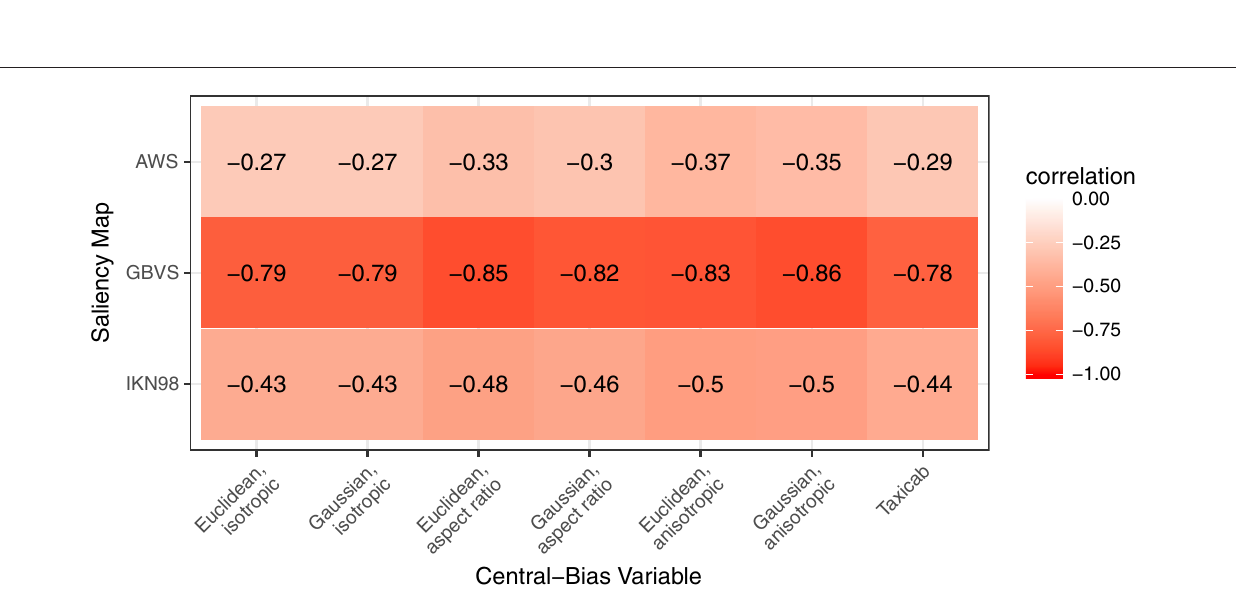
Frontiers in Human Neuroscience |